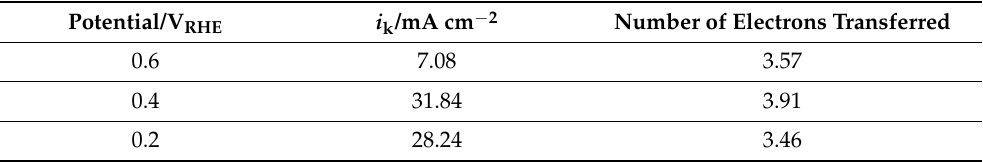
Table 1. Kinetic parameters estimated from the Koutecky–Levich plots of the ultrafine TaO x /CB nanoparticles shown in Figure